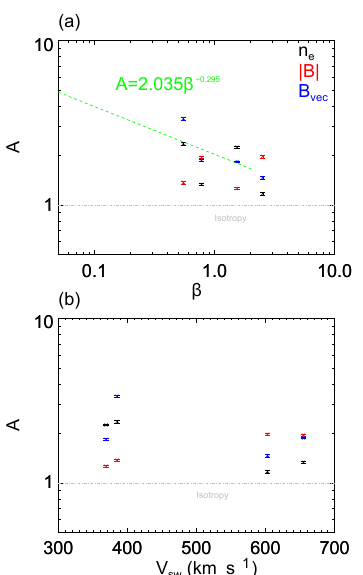
Figure 2. (a) Evolution of the anisotropy index with plasma β . Black, red and blue denote the anisotropy indices obtained from density, compressible magnetic and total magnetic field, respec- tively. The green line denotes the empirical relationship between the anisotropy index and the β (Comi¸sel et al., 2014). (b) The value of the anisotropy index as a function of solar wind